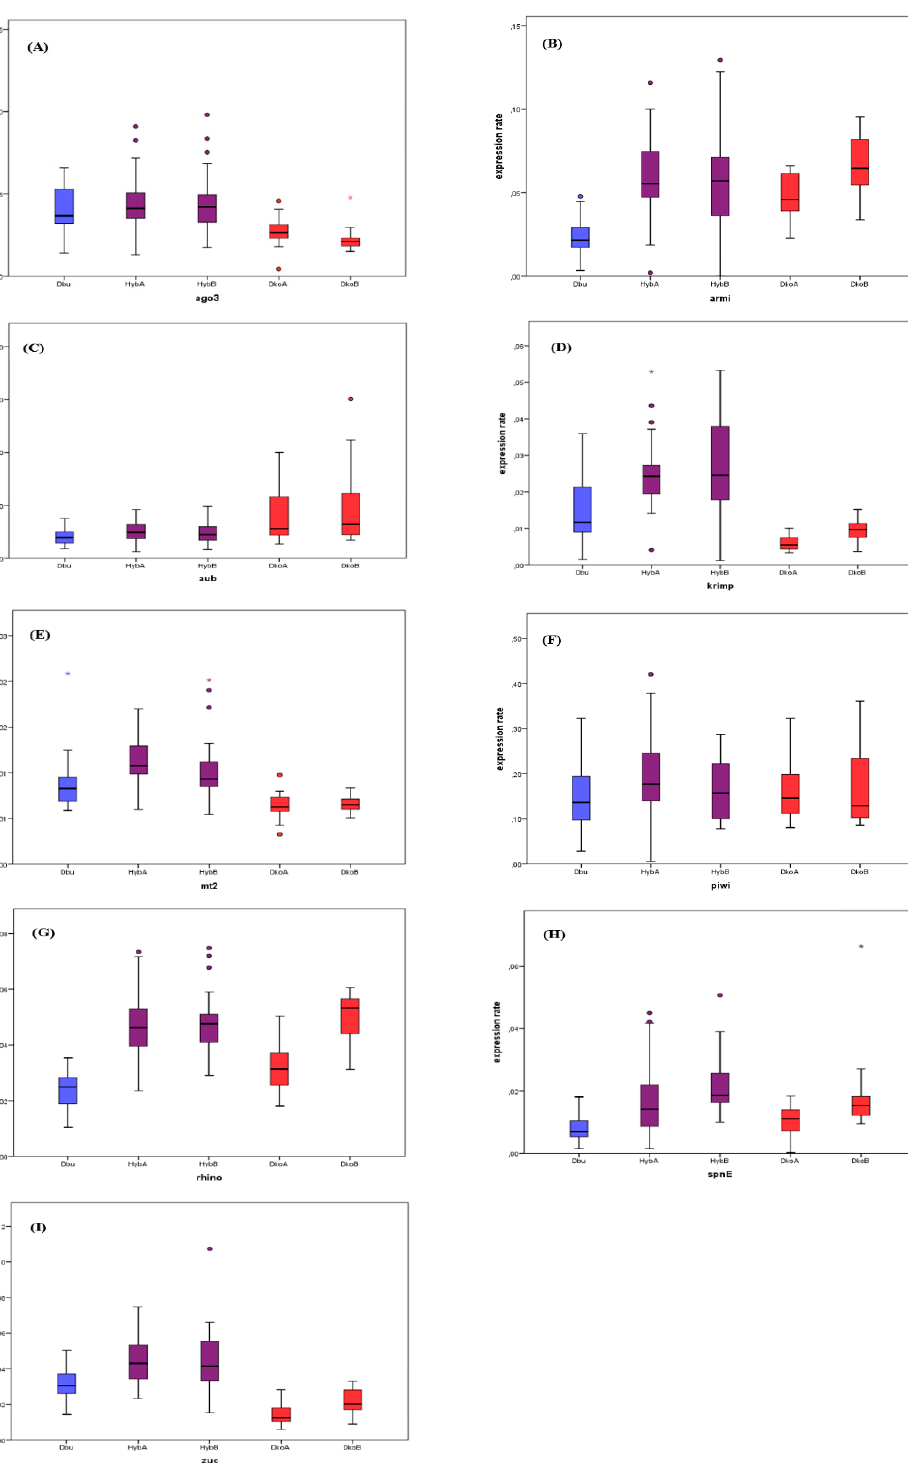
Figure 2. Expression rates relative to rp49 housekeeping gene in parental species ( Dko and Dbu ) and hybrids. Boxes are determined by the first and third quartile values, with an intermediate deep line corresponding to the median value. Circles correspond to outliers (above or below 1.5-fold the interquartile range) and asterisks correspond to atypical values. Every group is shown in the same order in every plot: Dbu parental species, hybrids groups A and B and Dko maternal species groups A and B. Graphics from ( A ) to ( I ) refer to each studied gene.